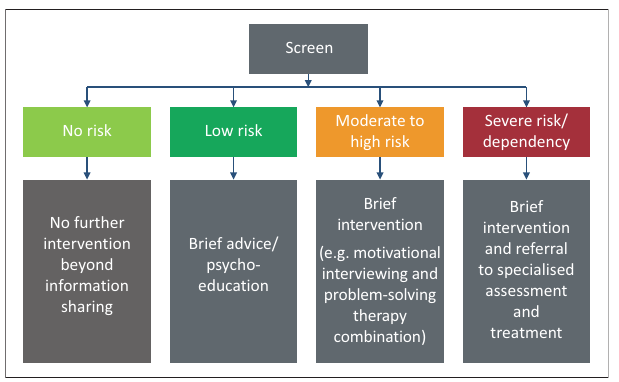
FIGURE 1: Pathways following screening for harmful substance use. 50